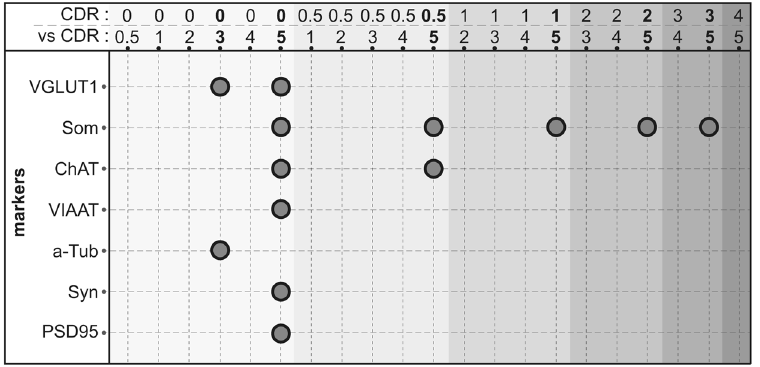
Figure 4. Visual representation of Kruskal-Wallis post hoc analysis output for synaptic markers among CDR scores. The first row represents the value of the CDR couples analysed (i.e., CDR0 vs. CDR0.5 for the first comparison). Significant differences are highlighted for each marker by a dark circle (p < 0.05). Som (somatostatin); α -tub ( α -Tubulin); Syn